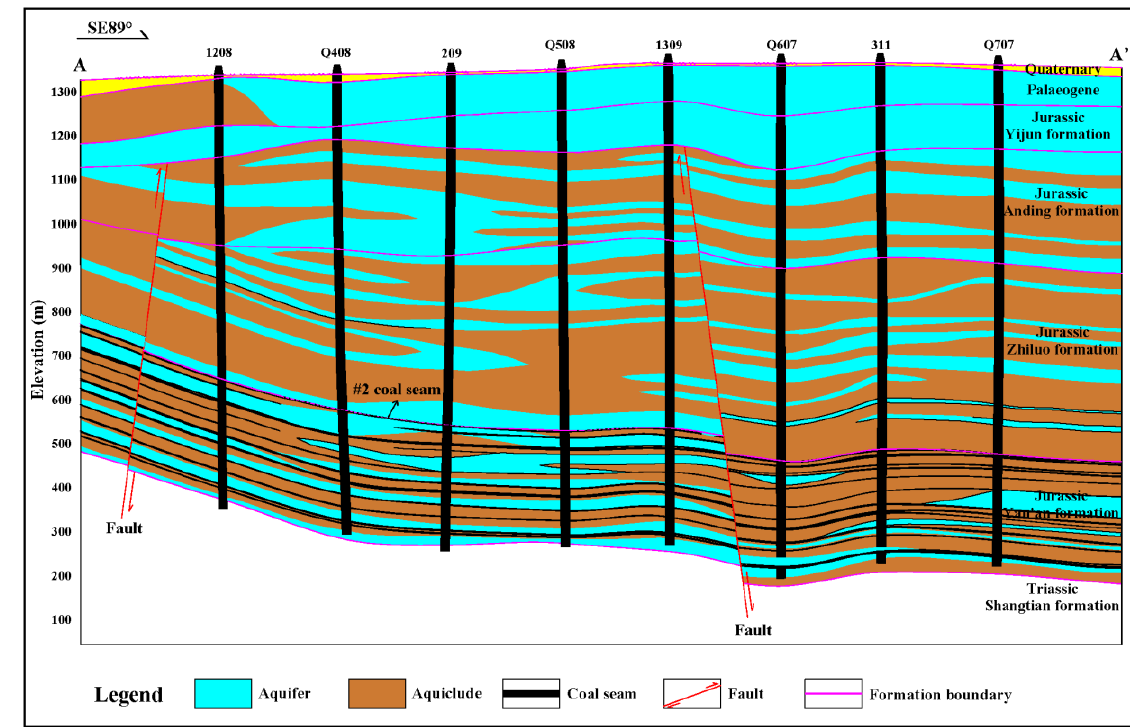
Figure 3. Hydrogeological profile of Qingshuiying Coalfield.